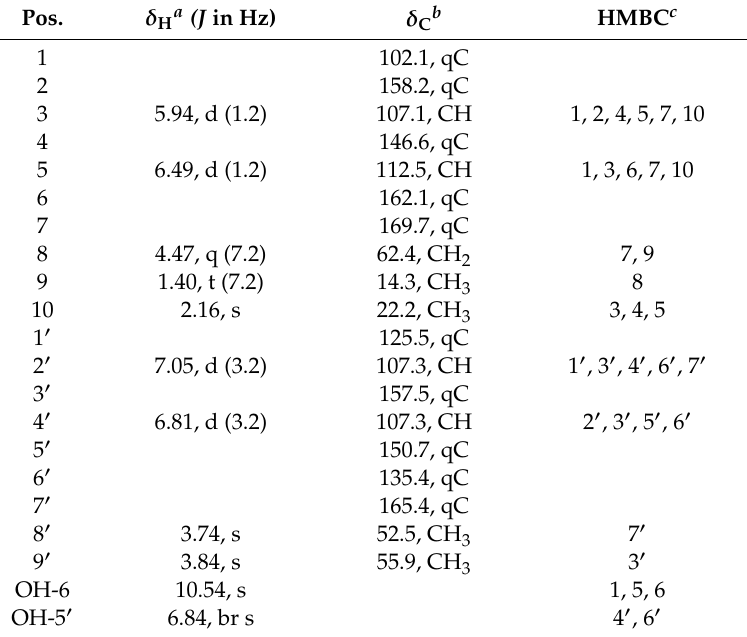
Table 3. NMR data for compound 8 (CDCl 3 ).